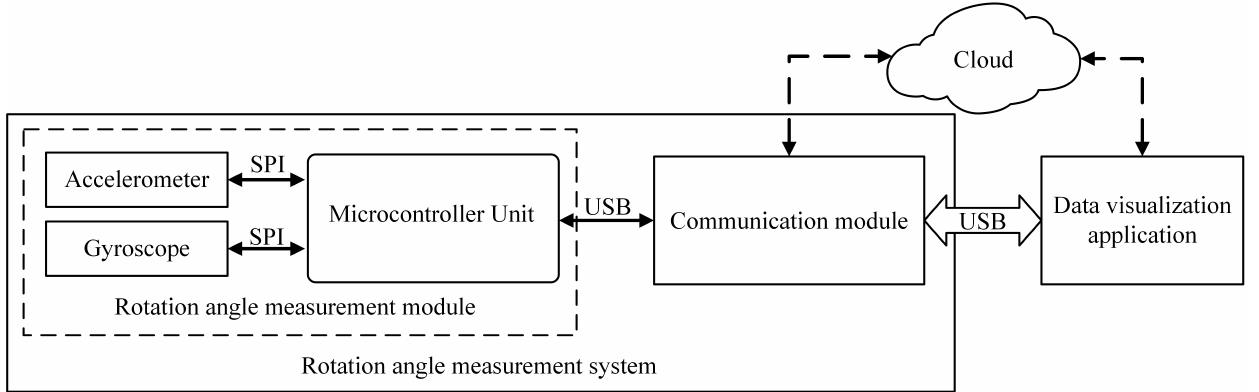
Figure 10. Rotation angle measurement system